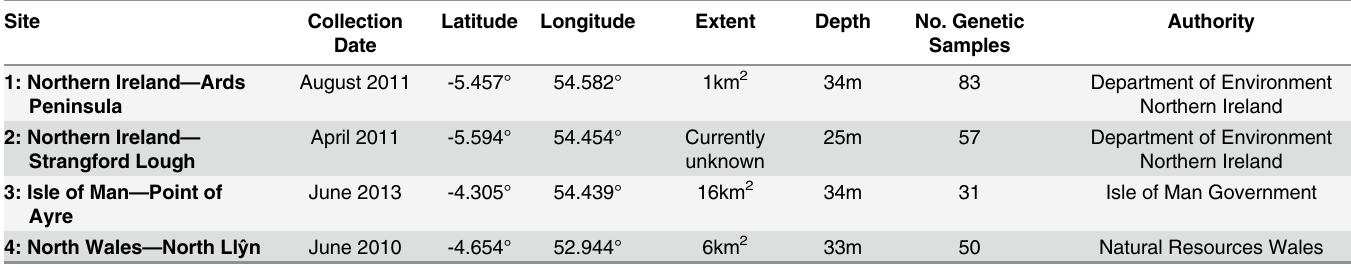
Table 1. Modiolus modiolus reefs populations